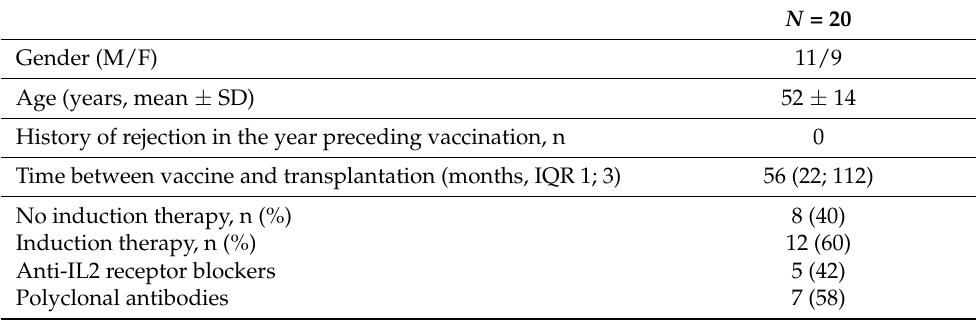
Table 1. Patients’